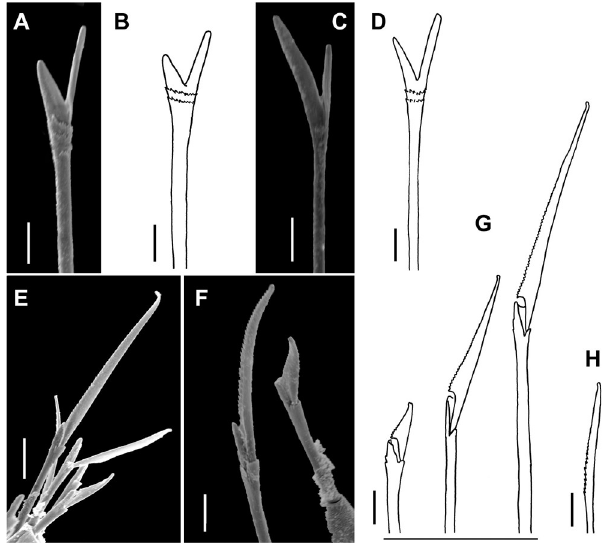
Fig 16. Meiodorvillea hartmanae sp. nov. (A,B) furcate chaeta, anterior region; (C,D) furcate chaeta, posterior region; (E,F,G) compound chaetae; (H) cultriform chaeta. Scale bars: (A,C,F) = 5 μ m; (E) = 10 μ m; (B,D,G,H) = 6.25 μ m.